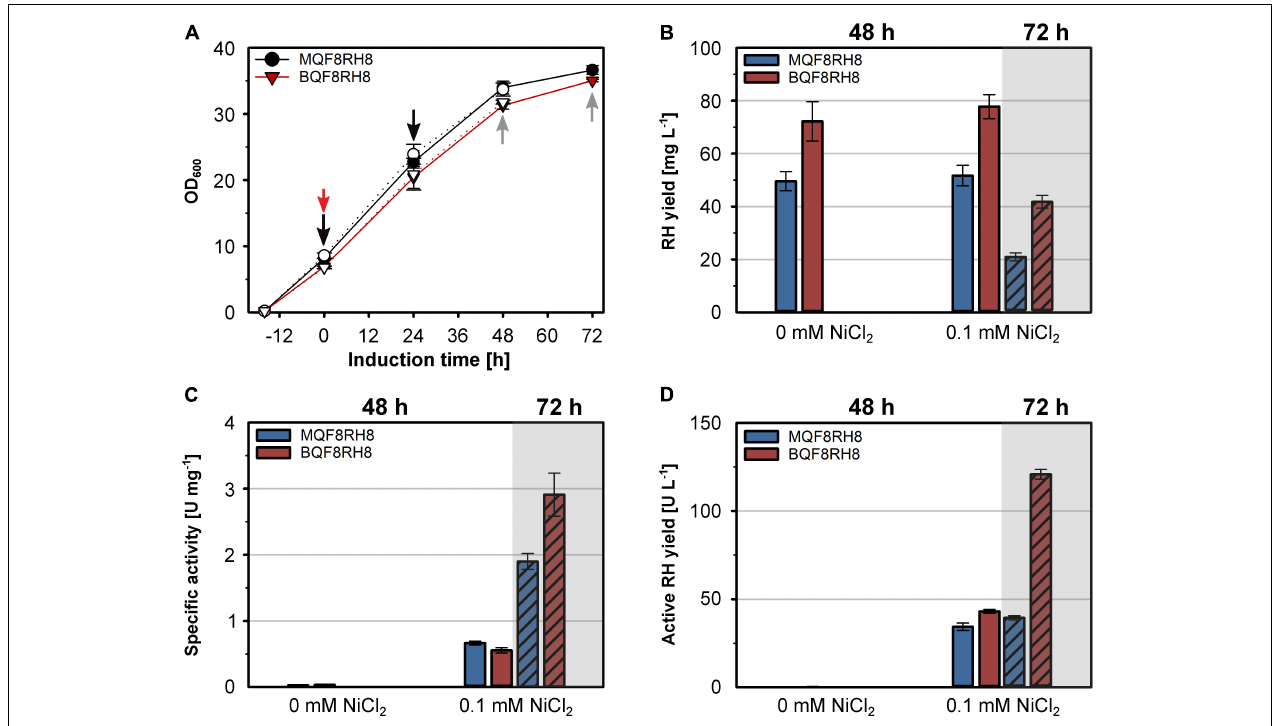
FIGURE 7 | Production of active RH in aerated cultures of E. coli BL21 Gold. E. coli strains MQF8RH8 and BQF8RH8 were cultured in 50 mL boosted EnPresso B medium at 18 ◦ C under aerobic conditions. RH gene expression was induced with 50 µ M IPTG and cells harvested 48 h or 72 h (hatched columns) after induction. NiCl 2 was added at the time point of induction of gene expression as indicated. (A) Cell growth. The time point of induction is indicated by a red arrow, while the time points of booster addition and cell harvest are indicated by black and gray arrows, respectively. Open and filled symbols represent growth of E. coli with or without 0.1 mM NiCl 2 , respectively. (B) RH protein was purified by affinity chromatography, and the yield was quantified. (B) specific activities measured from the purified RH samples. (D) Volumetric yield of RH calculated from the results in panels (B,C)